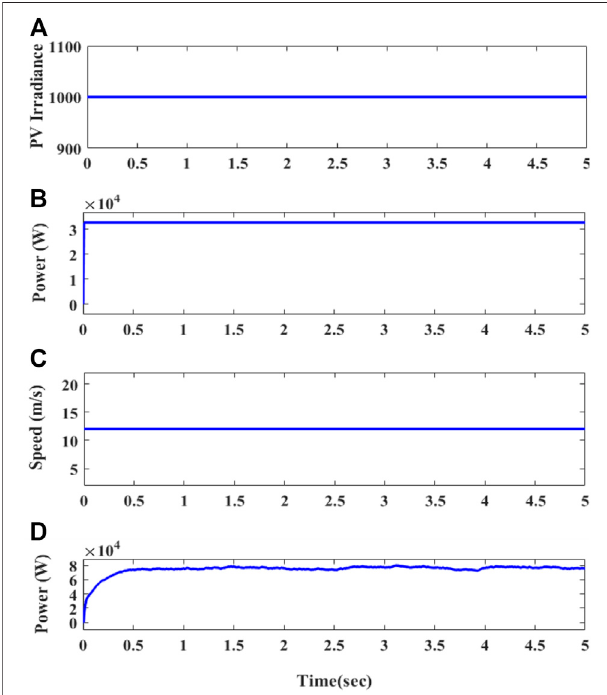
FIGURE 19 | Power factor for phases A, B, and